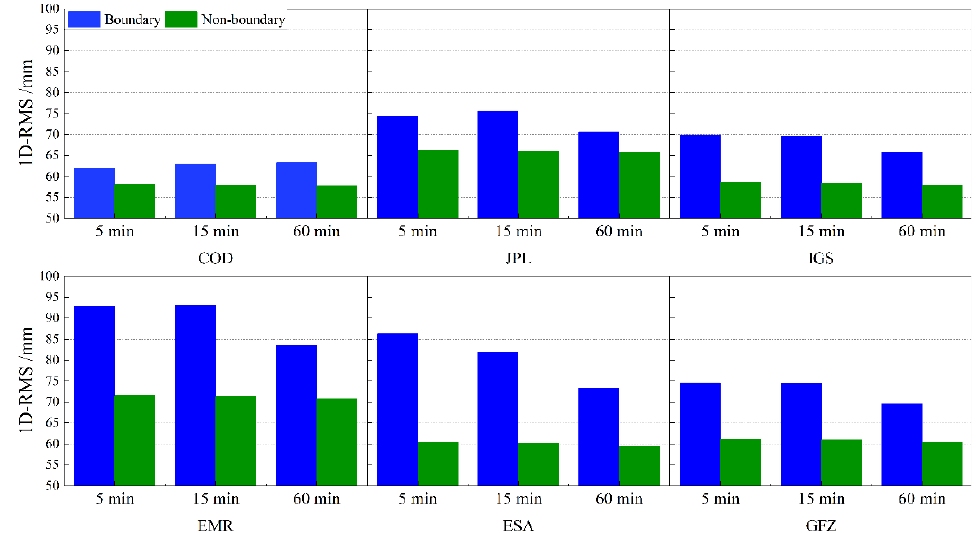
Figure 5. 1D ‐ RMS of PPP with different durations of original input (unit: mm). Figure 5. 1D-RMS of PPP with different durations of original input (unit: mm). Table 3. 1D ‐ RMS boundary and non ‐ boundary accuracy statistics (unit: mm).